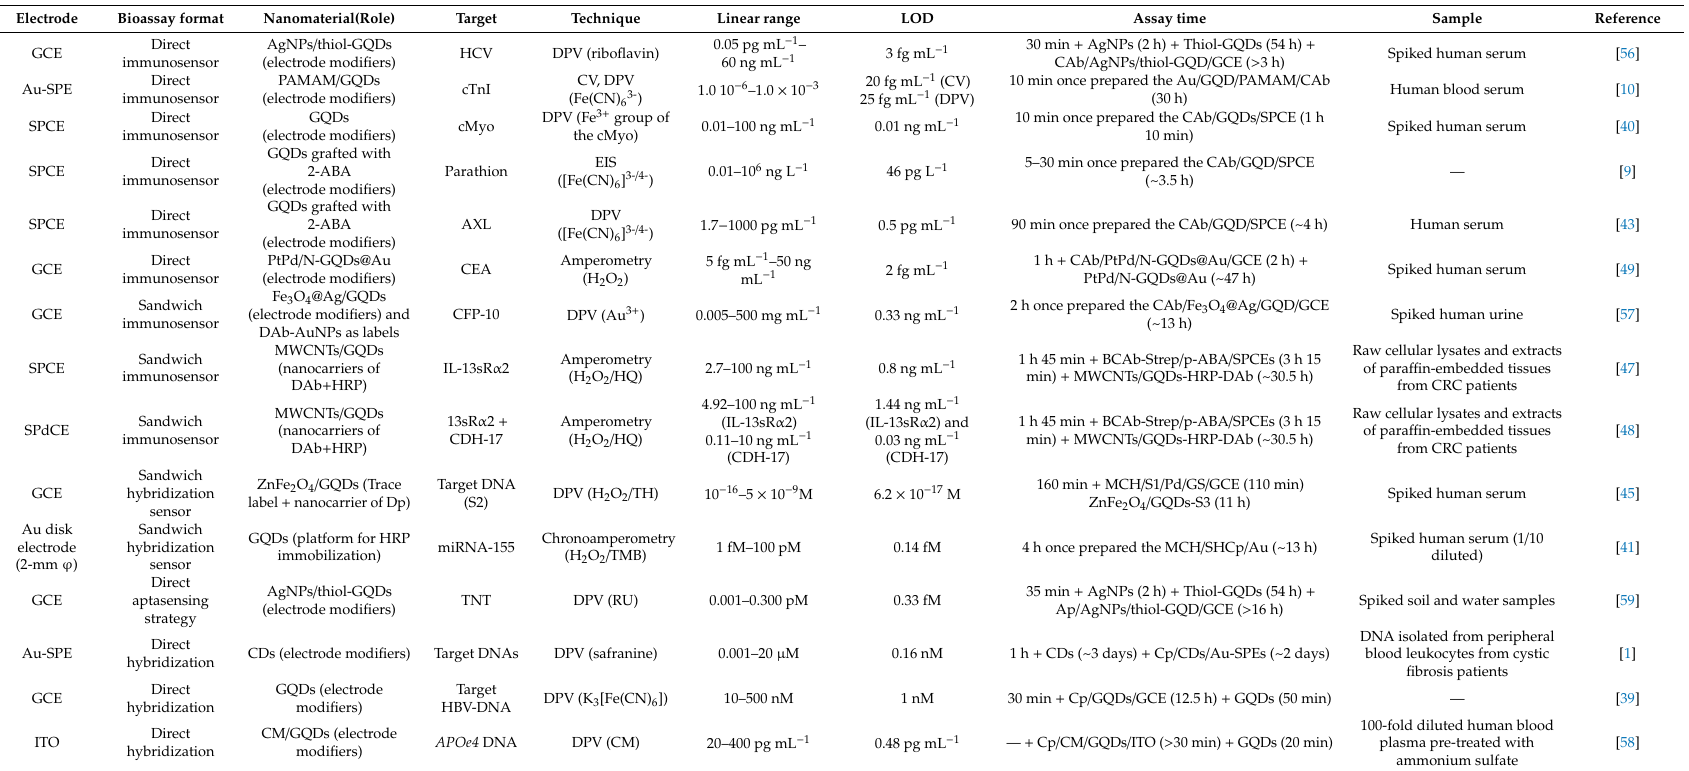
Table 1. Electrochemical a ffi nity biosensors reported over the last five years involving the use of GQDs or CDs.